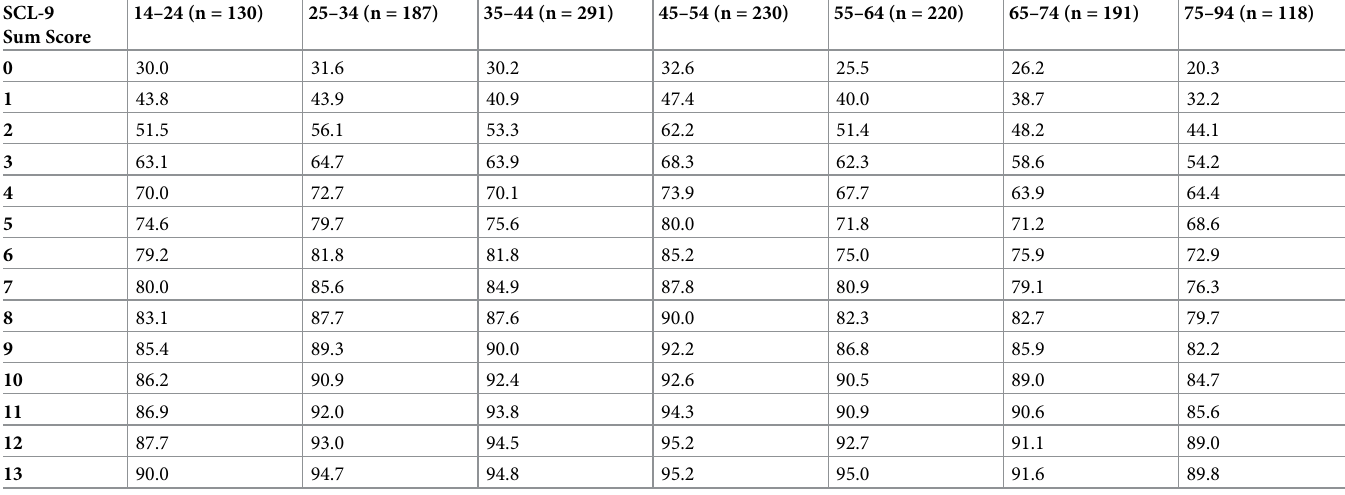
Table 6. Normative percentile values: